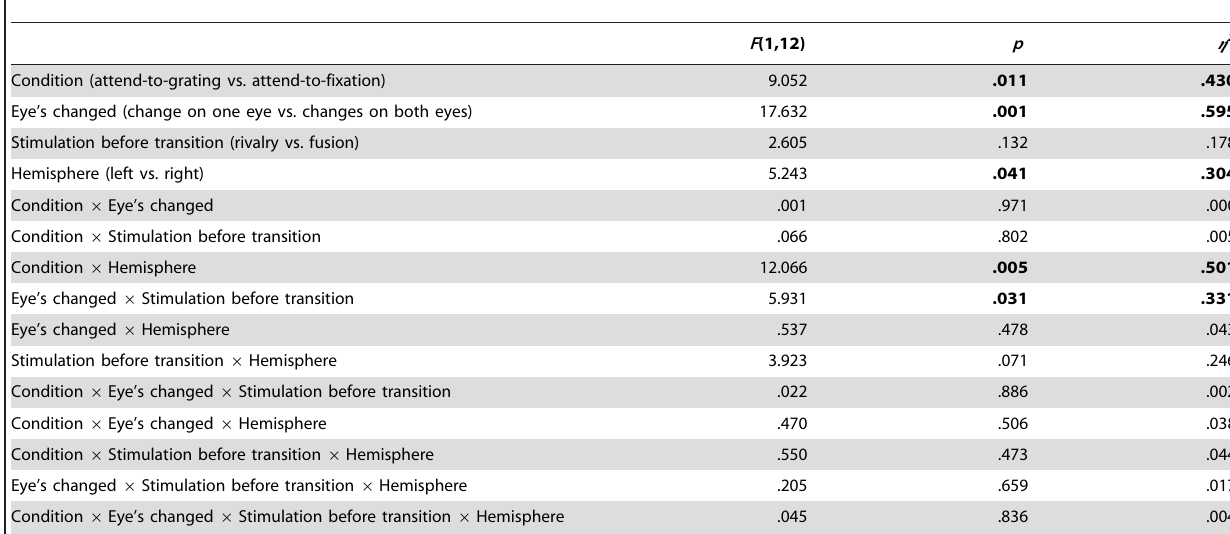
Table 1. Results of the repeated-measures ANOVA for the differences between the N1 amplitude and the ERP amplitude in the post-N1 interval (210 ms to 300